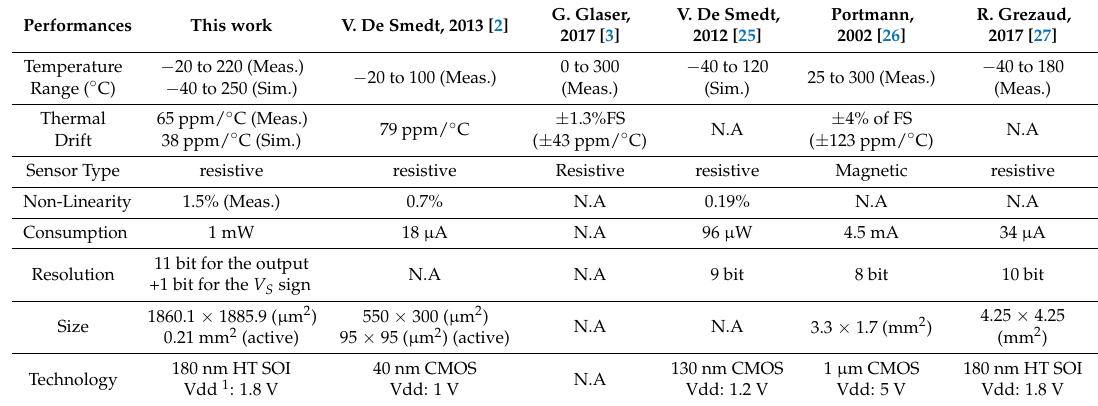
Table 1. Performances of the sensor